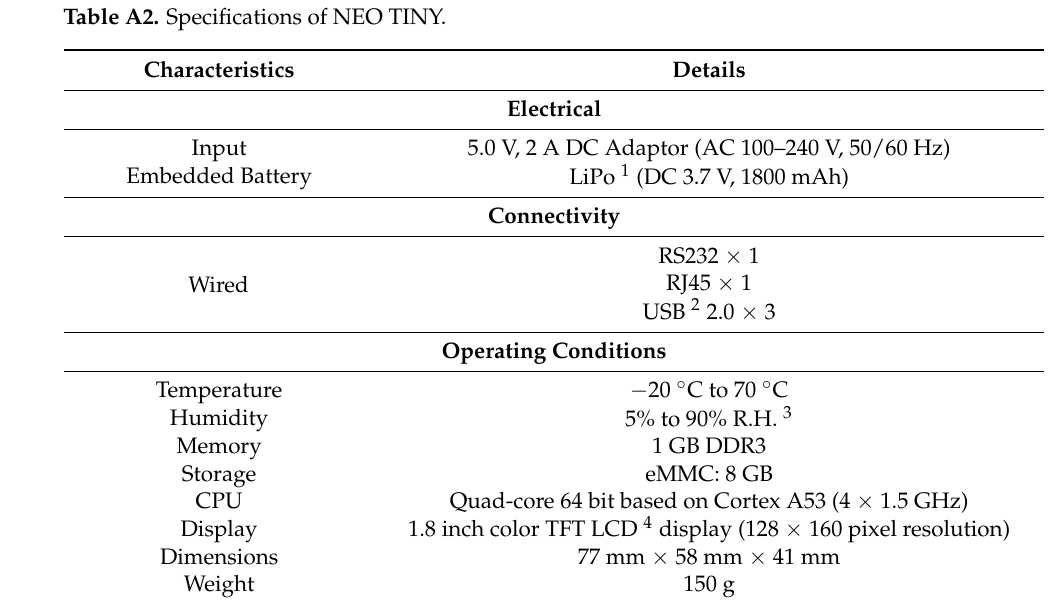
Table A2. Specifications of NEO TINY.